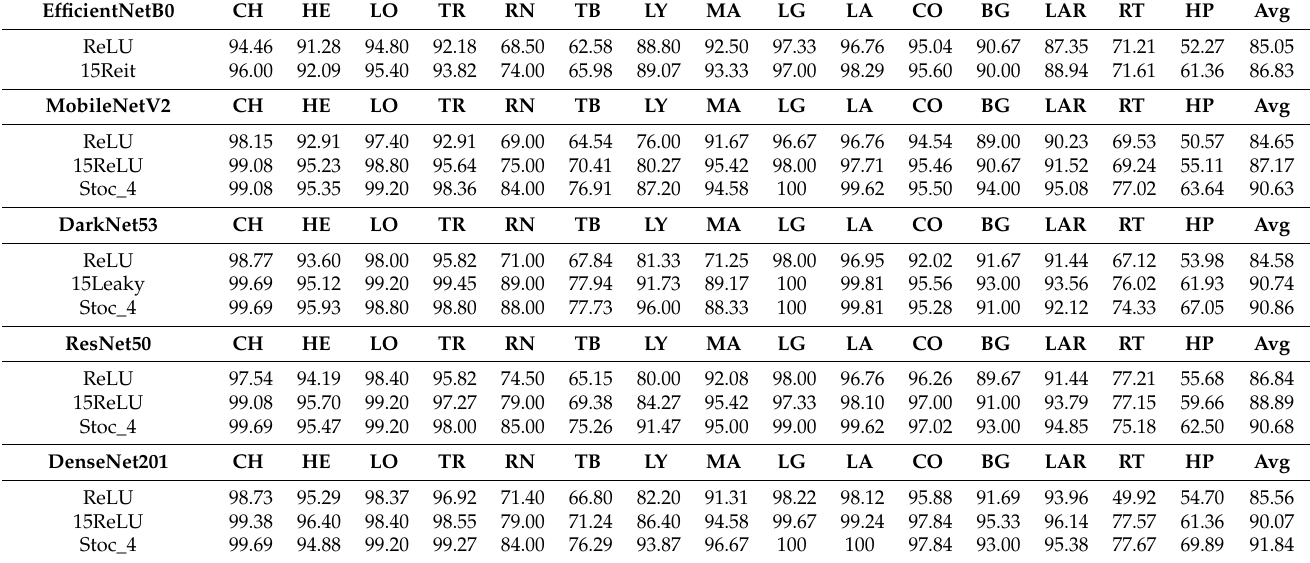
Table 6. Ensemble performance (accuracy) on a set of different topologies (due to the high compu- tational time for CO we have run only 4 Sto_4 Densenet201).